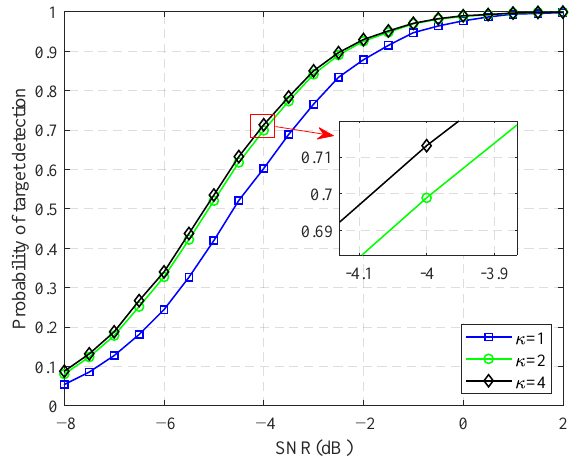
Figure 7. Detection probability when P fa = 10 − 5 .